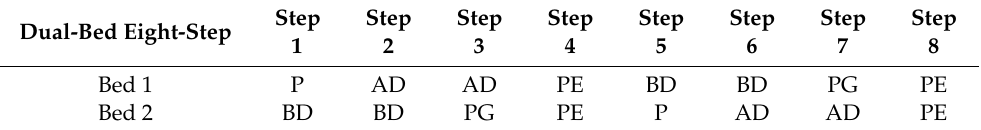
Table 5. Steps of the dual-bed eight-step process.